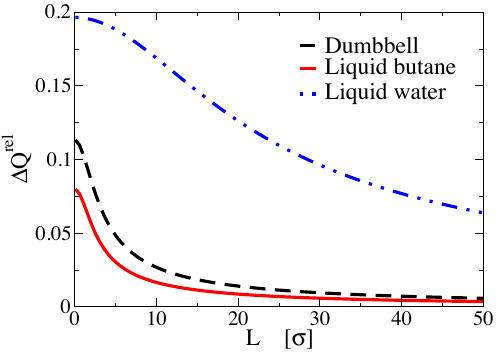
Q ENS ) / Q NS between predictions Figure 2. Calculated relative flow rate reduction ∆ Q rel = ( Q NS − of the Navier–Stokes equations and extended Navier–Stokes equations (including spin angular momentum coupling) for a dumbbell fluid, liquid butane, and liquid water in planar Poiseuille flow. The horizontal axis represents the channel width in units of the Lennard–Jones intermolecular potential parameter σ . σ = 3.92 Åand 3.17 Åfor butane and water, respectively. Reprinted